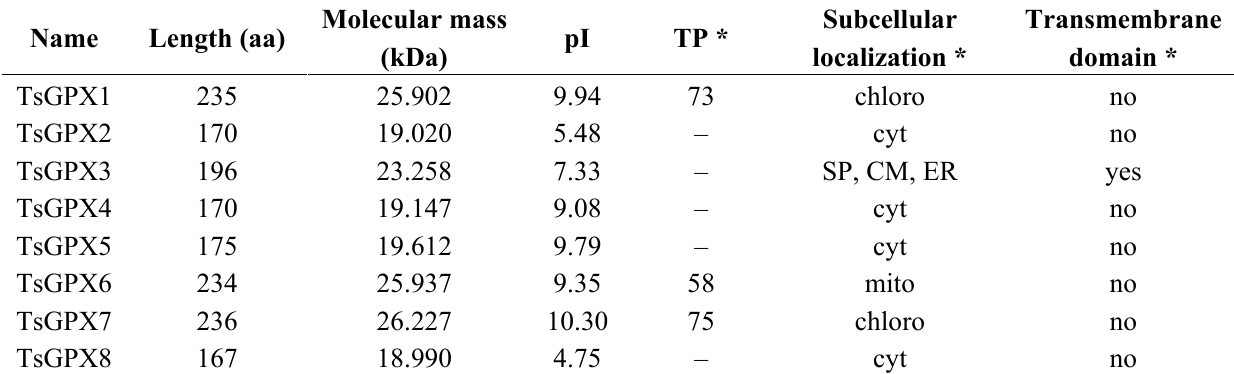
Table 3. The physical and chemical properties of